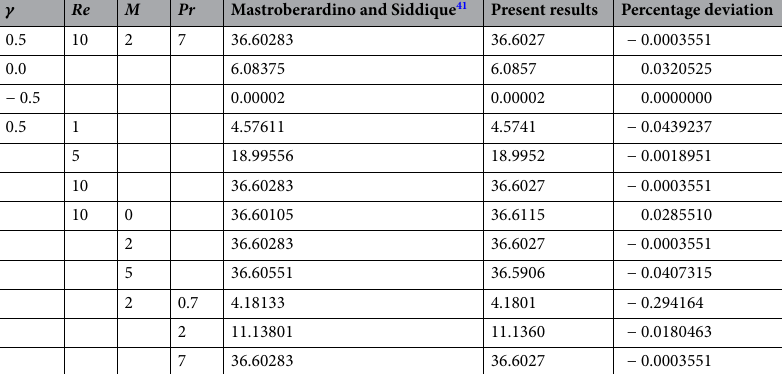
Table 3. Nusselt number table for varying γ , Re , M , and Pr .